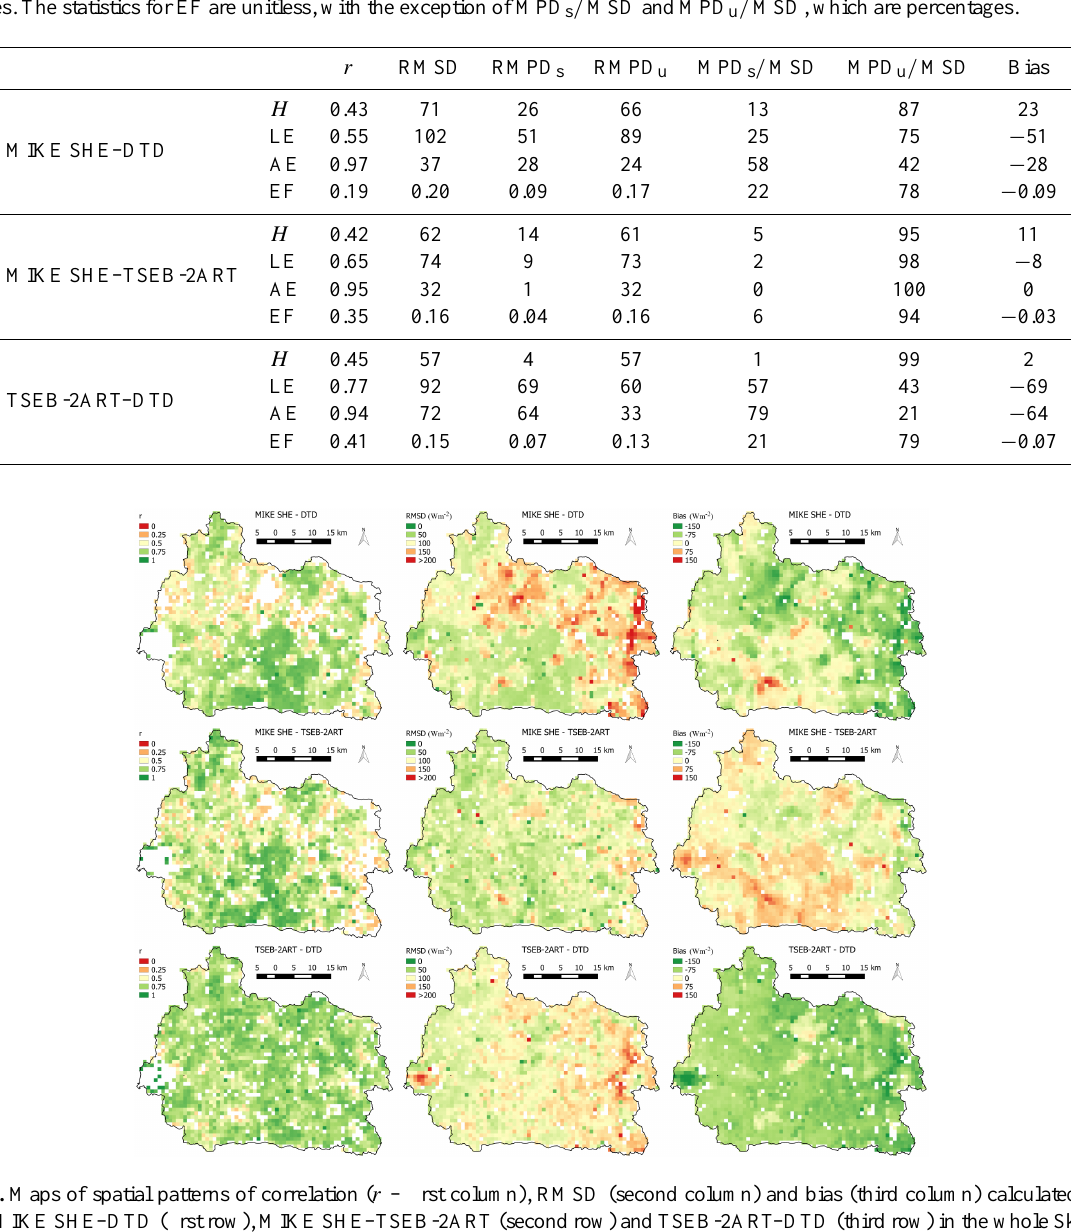
Table 5. Statistical comparison between MIKE SHE, DTD and TSEB-2ART models for sensible and latent heat fluxes ( H and LE), available energy (AE) and evaporative fraction (EF) for flux estimates when LAI < 4. Statistics used: correlation coefficient ( r ), root mean square difference (RMSD), systematic and unsystematic root mean product differences (RMPD s and RMPD u respectively), the percentage of mean square difference (MSD) attributed to systematic and unsystematic mean product differences (MPD) (MPD s / MSD and MPD u / MSD respectively) and bias. The statistics for H , LE and AE are in Wm − 2 , with the exception of MPD s / MSD and MPD u / MSD, which are percentages. The statistics for EF are unitless, with the exception of MPD s / MSD and MPD u / MSD, which are percentages.